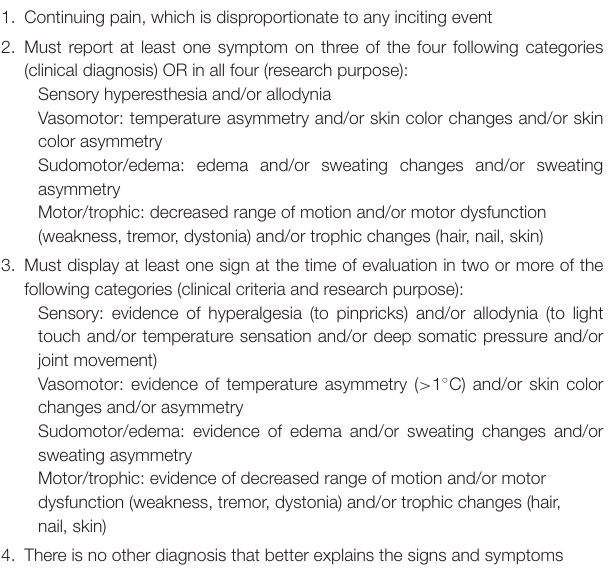
TABLE 1 | The “Budapest Criteria” for complex regional pain syndrome (CRPS)